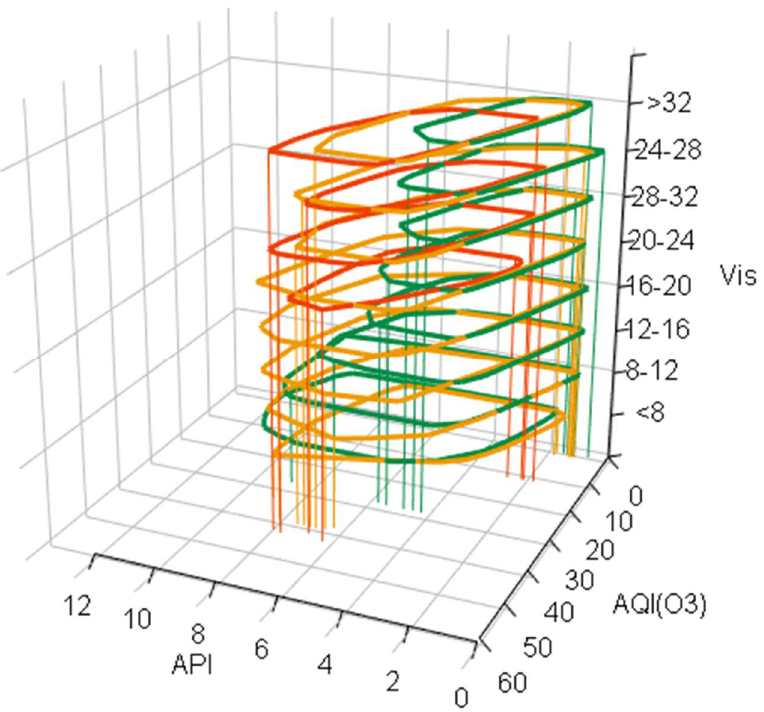
Figure A15. Effect of visibility-dependent air O 3 concentration on the air pollution index for the rainy season in spring, summer and winter.